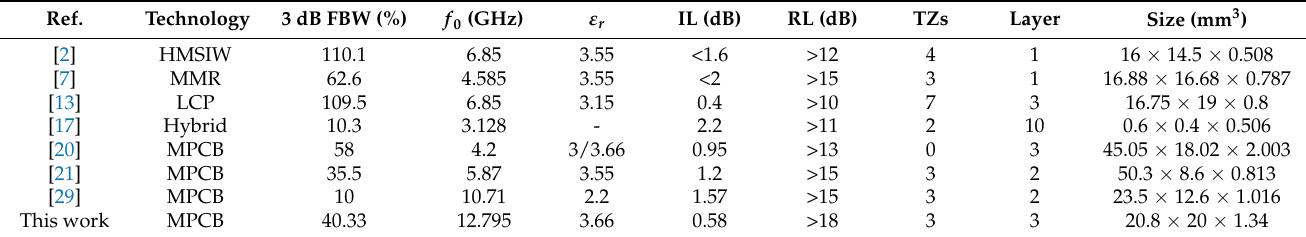
Table 2. Comparison of performance with other designed